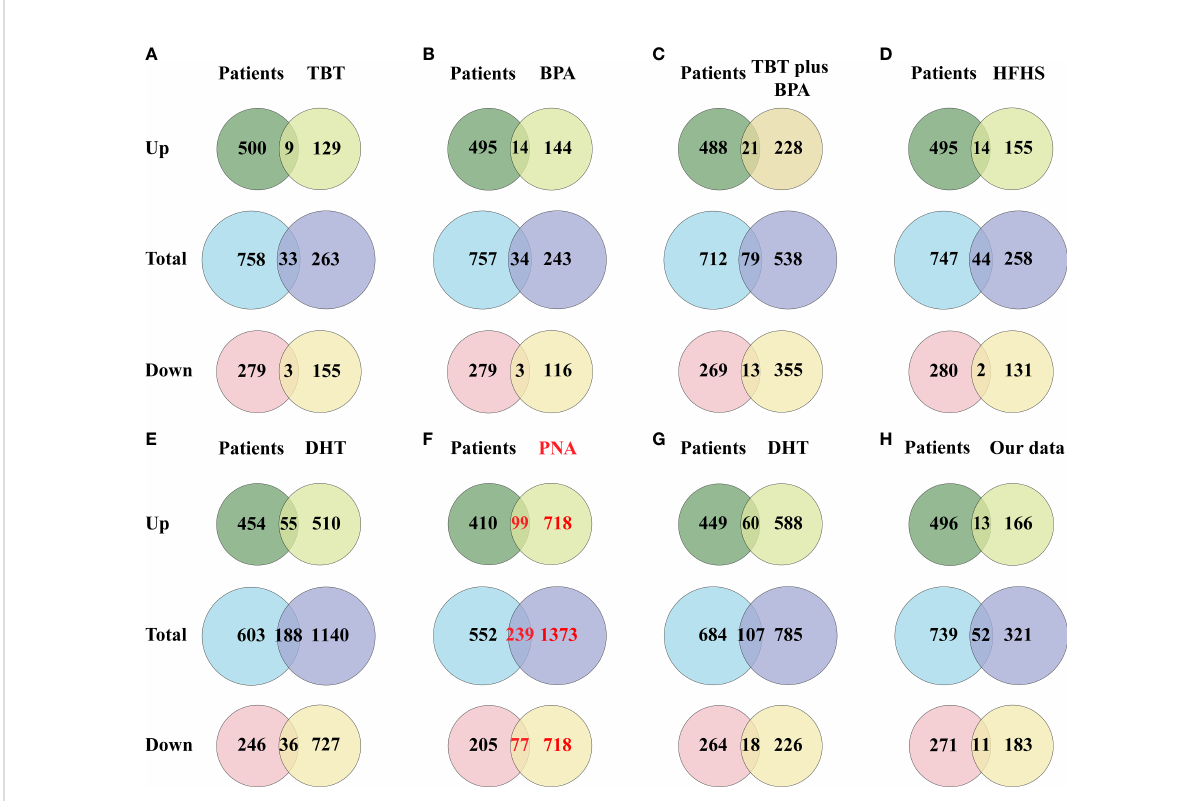
FIGURE 3 Venn diagram showing the intersection of DEGs (including up-regulated genes and down-regulated genes) between the PCOS animal modeland patients. (A) DEGs of the TBT-induced PCOS rat model. (B) DEGs of the BPA-induced PCOS rat model. (C) DEGs of the TBT plus BPAinduced PCOS rat model. (D) DEGs of the HFHS-induced PCOS rat model. (E) DEGs of the DHT-induced PCOS rat model. (F) DEGs of the PNA PCOS mouse model. (G) DEGs of the DHT-induced PCOS mouse model. (H) DEGs of the DHEA plus HFD-induced PCOS mouse